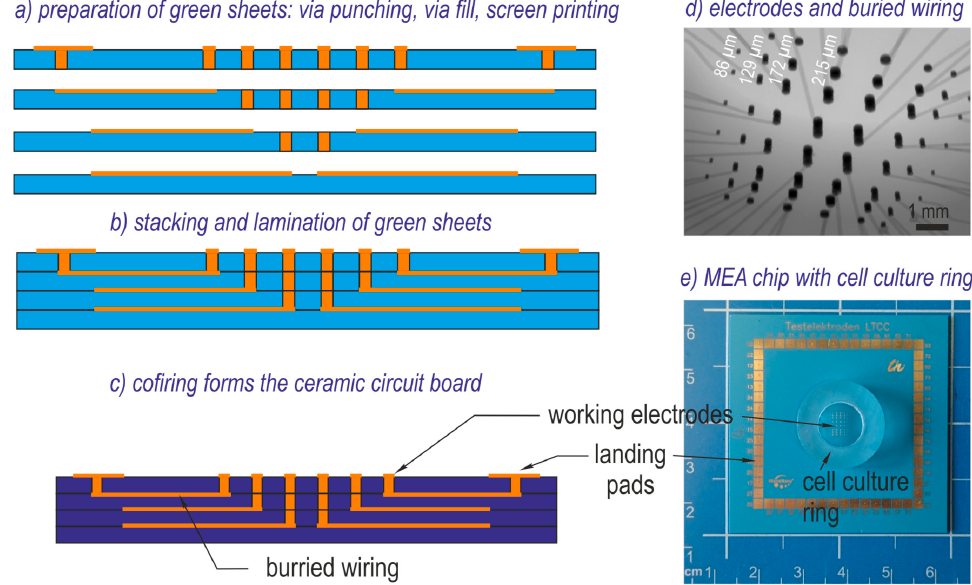
Figure 1. Planar multi electrode array (pMEA) made of low temperature cofired ceramic (LTCC): ( a